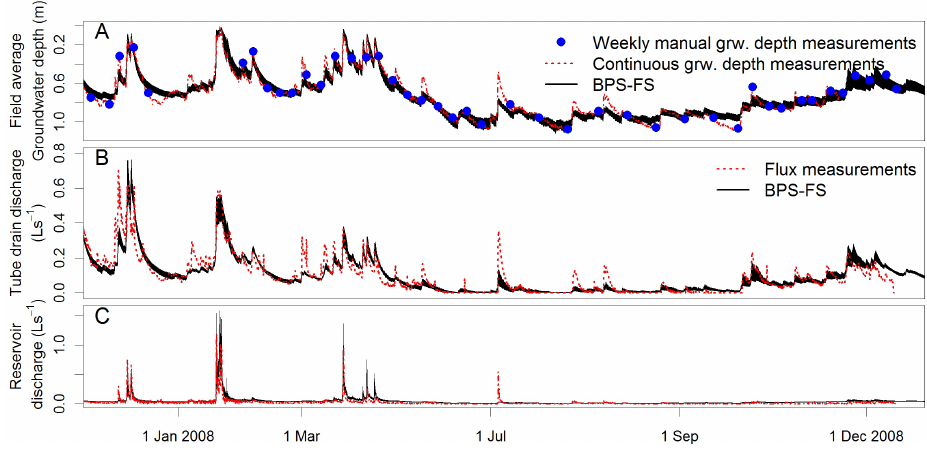
Fig. 5. Measurements and simulation results of the field site model (BPS-FS) for the spatially averaged groundwater depth (A) , tube drain discharge (B) , and reservoir discharge (combined flux of overland flow and groundwater flow, C ) of the field-site. The black band gives the results of all behavioral parameter sets